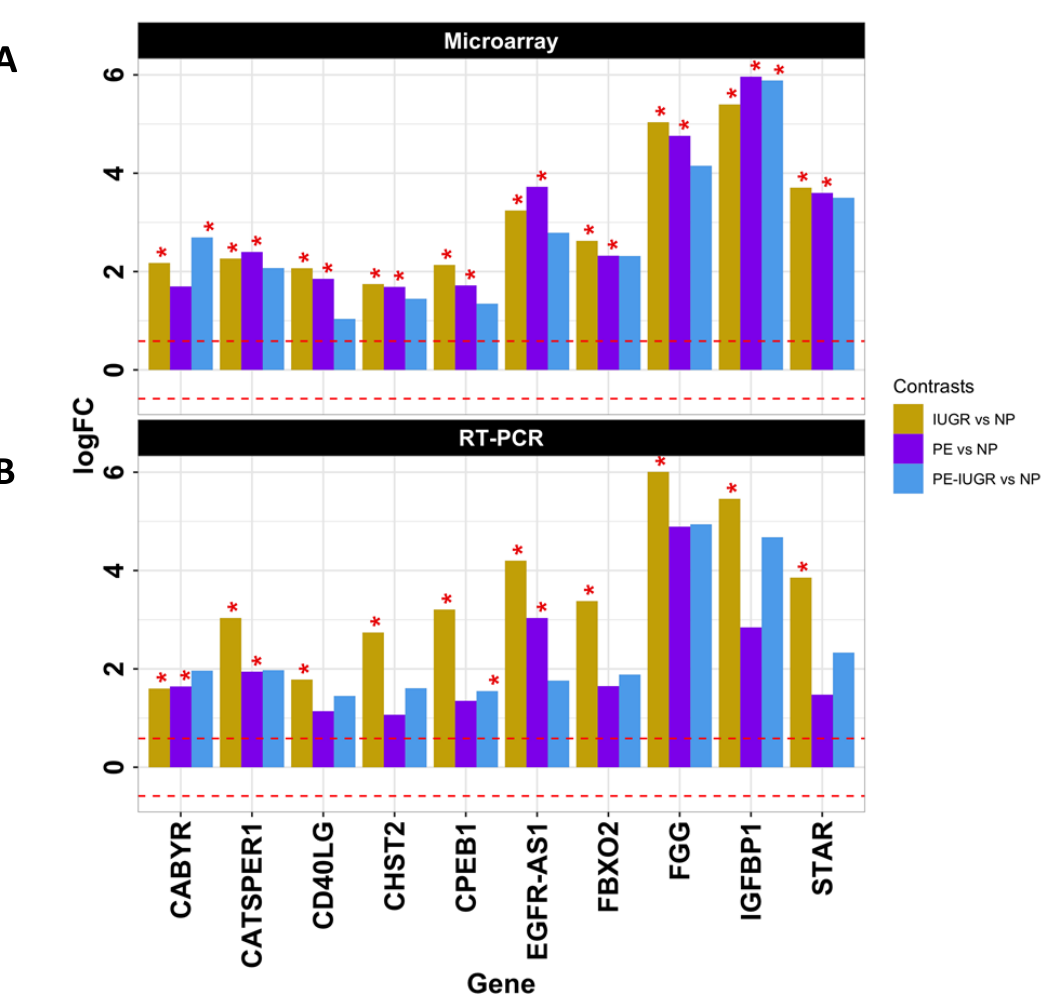
Figure 4. Validation of selected di ff erentially expressed genes. Genes with the highest log2 fold-change and / or involvement in top-20 biological, molecular, or pathological processes were selected, and their expression change was evaluated independently by an orthogonal RT-PCR method. ( A ) Bar plot represents log2 fold-changes results from microarray data, plotted on the y -axis, for each gene, here depicted horizontally. The asterisks indicate where change was statistically significant (i.e., FDR < 0.1) and the horizontal dashed red lines marks the fold-change threshold considered as significant ( − 1.5 < fold-change > 1.5. ( B ) Bar plot represents delta-delta-Ct (-DDCT) results from RT-PCR data, plotted on the y -axis, for each gene, here depicted horizontally. The asterisks indicate where change was statistically significant (i.e., p -value < 0.05) and the horizontal dashed red lines marks the fold-change threshold considered as